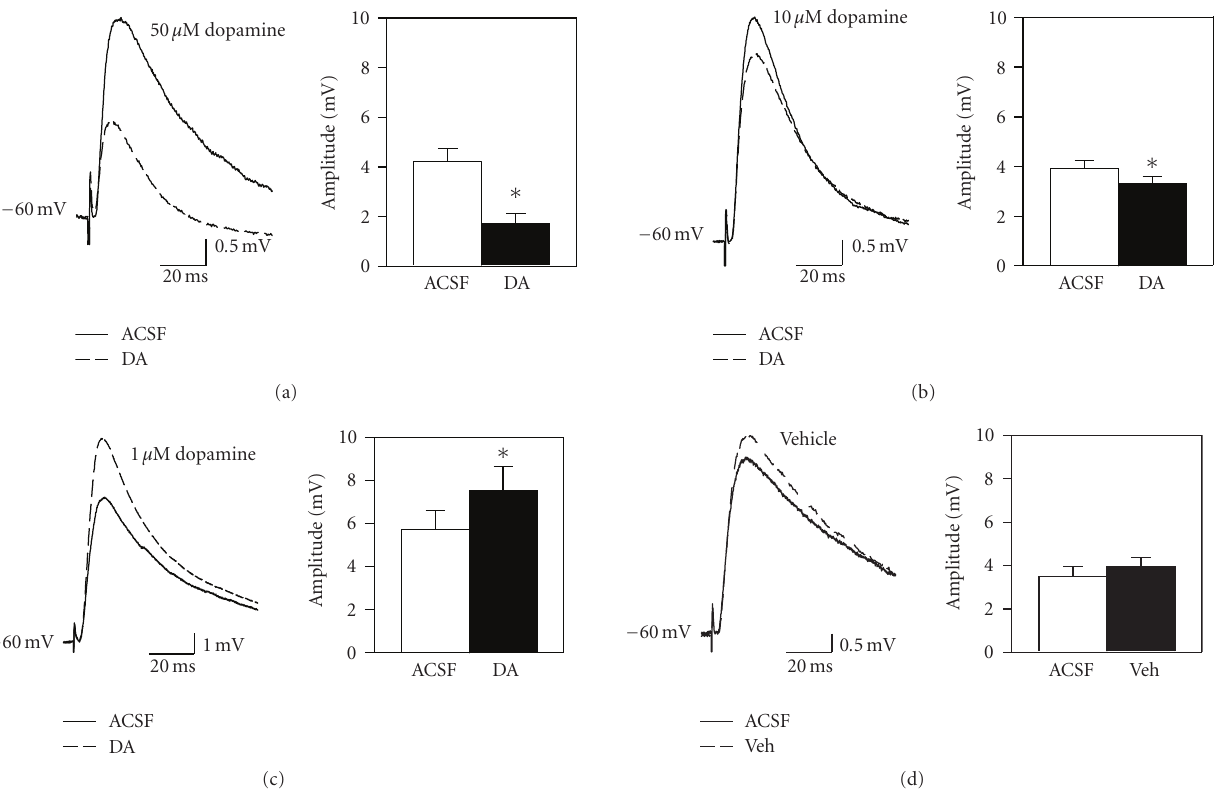
Figure 1: Dopamine has dose-dependent and bidirectional e ff ects on the amplitude of mixed EPSPs in layer II fan cells. (a) Fifty μ M dopamine significantly reduces the amplitude of synaptic responses. Traces show averaged EPSPs before (ACSF) and after 5-minute bath application of dopamine (DA) in a representative cell. Group data indicate the mean amplitude of EPSPs before and after dopamine ( ∗ , P < . 001). Bars indicate ± 1 SEM in this and subsequent figures, and ∗ indicates P < . 05 unless otherwise indicated. (b) A lower concentration of 10 μ M dopamine causes a smaller suppression of synaptic responses. (c) The low 1 μ M concentration of dopamine enhances the amplitude of synaptic responses ( ∗ , P < . 01). (d) Bath application of vehicle (50 μ M sodium metabisulfite; Veh) does not significantly a ff ect synaptic